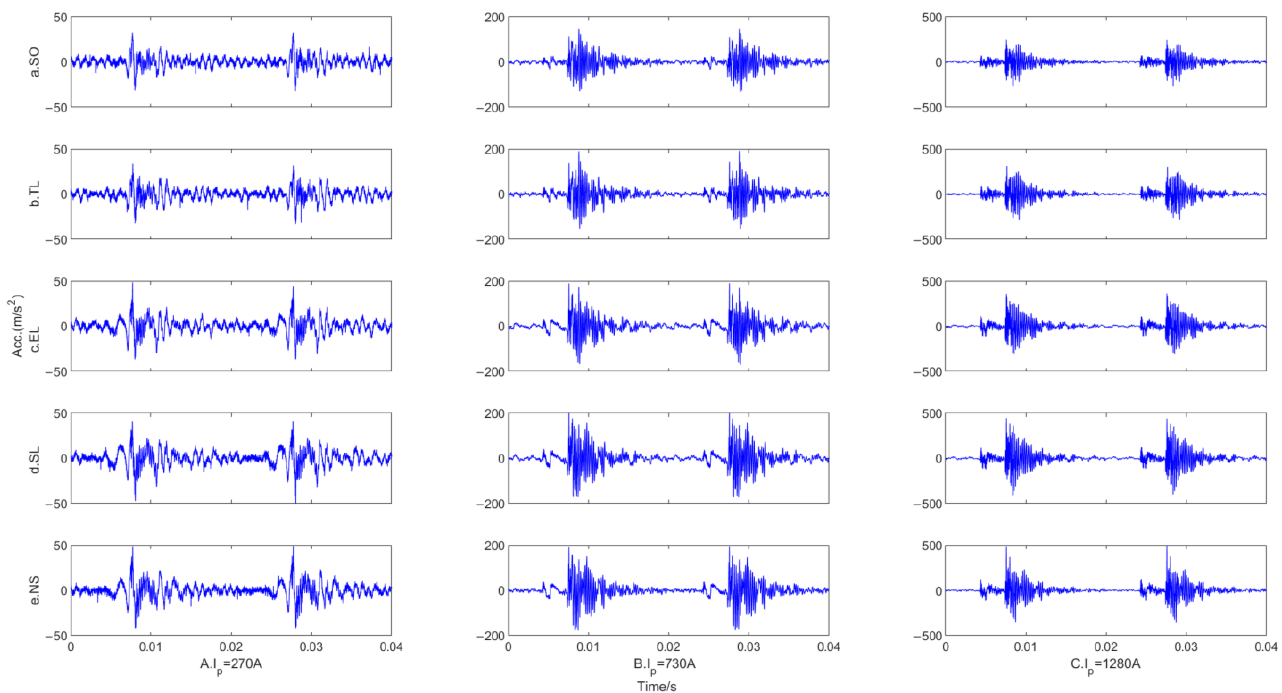
Figure 9. Comparison of the time domain vibration waveform of saturable reactors with different loose iron cores under various operating conditions. From top to bottom, a~e represent the five iron core looseness faults in Table 4. From left to right, A, B, and C represent that the current peak values are 270 A, 730 A, and 1280 A, respectively.